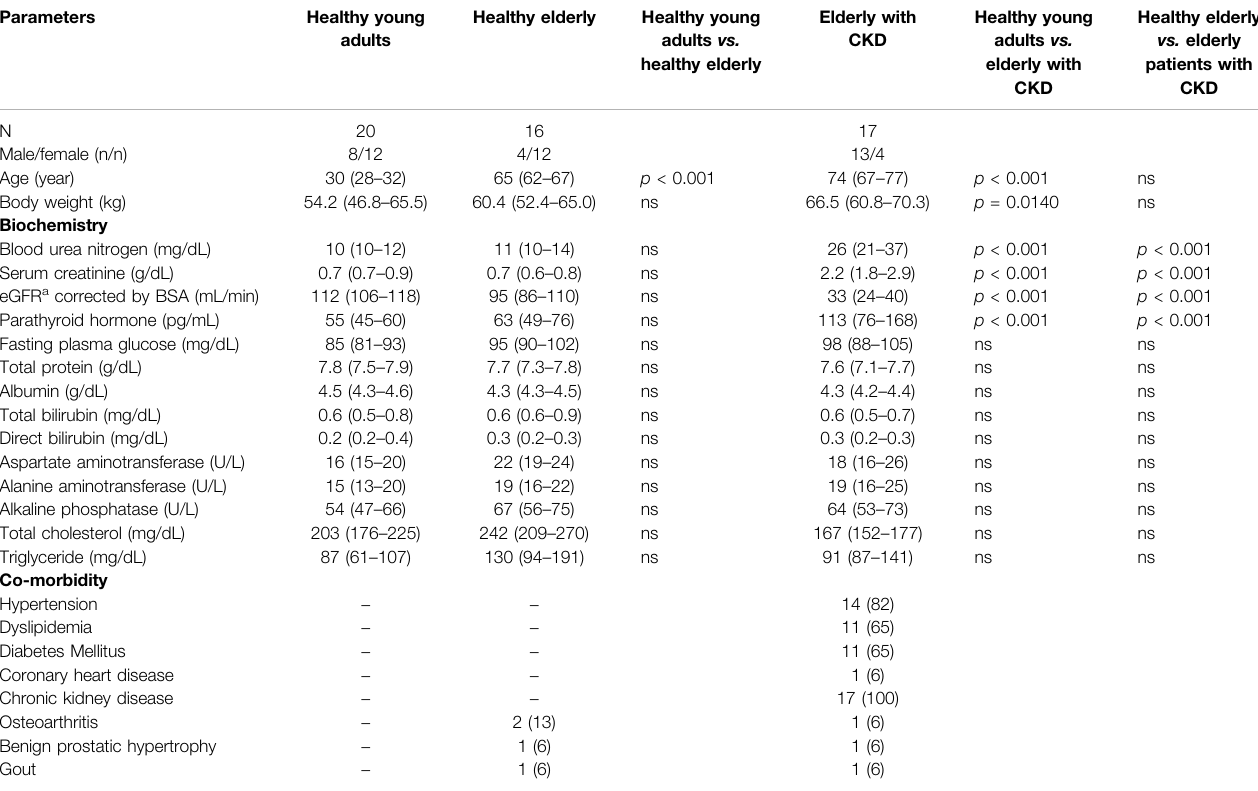
TABLE 1 | Baseline characteristics.